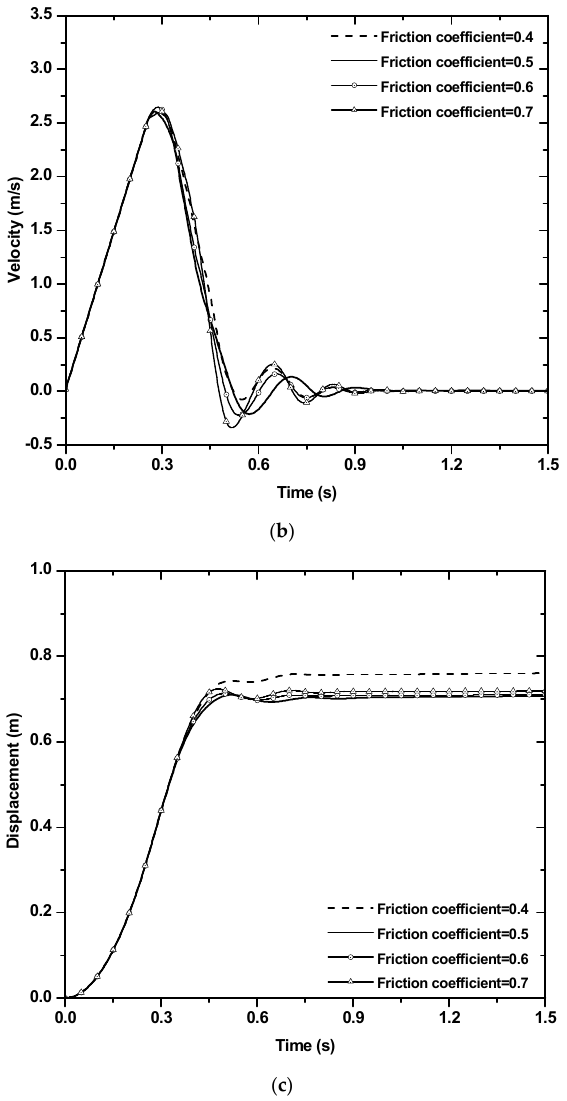
Figure 14. Vertical motion of weights clashing with gravel layers for different friction coefficients between the gravel and the weight (friction coefficient between gravel pieces = 0.5): ( a ) acceleration; ( b ) velocity; ( c ) displacement.